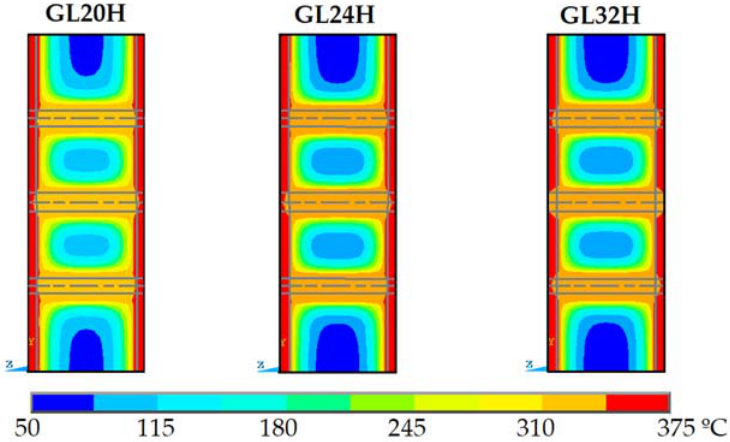
Figure 16. Temperature in the middle of the cross ‐ section of the connection for the time of 300 s. The results show that the temperature can vary between 50 and 375 °C. On the sur ‐